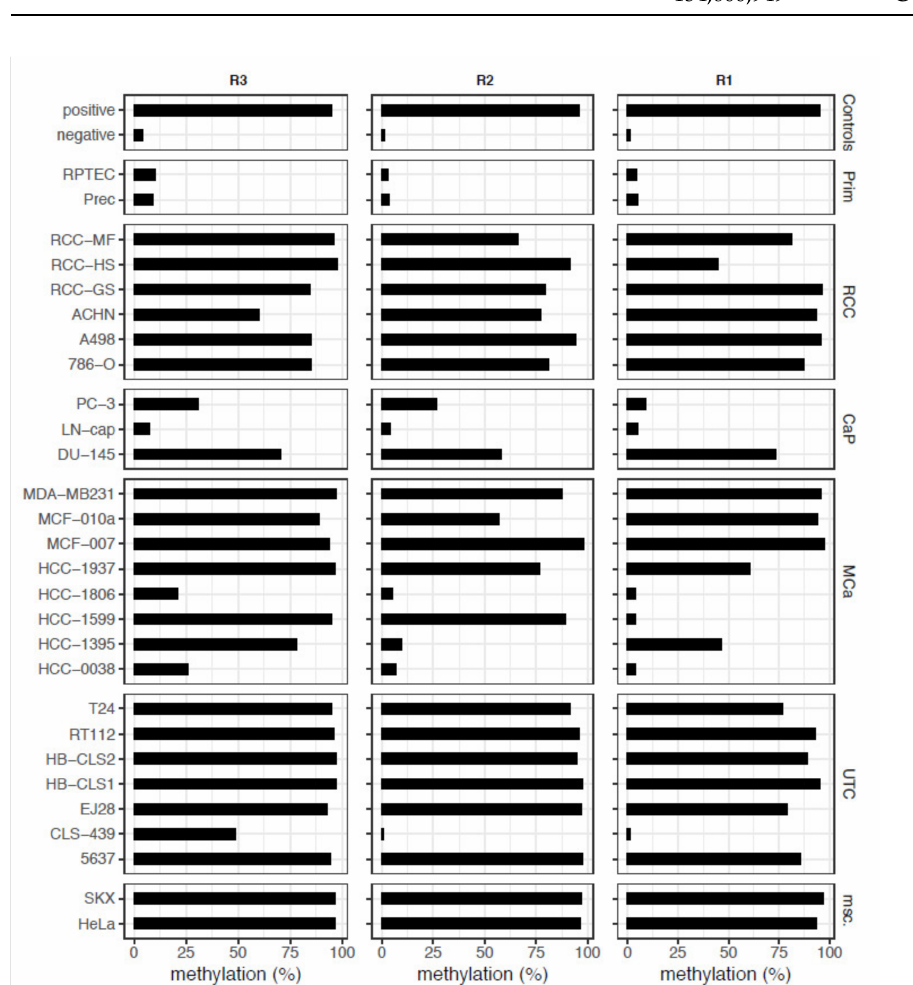
Figure 3. NKX6-2 methylation in regions R3-R1 in cell models. Pyrosequencing analysis provided relative methylation in the NKX6-2 R3-R1 regions in % of control DNA (Controls), normal primary cells (Prim), and tumor cells representing renal cell cancer (RCC), prostate cancer (CaP), mammary cancer (MCa), urothelial cancer (UTC), and miscellaneous (msc.)